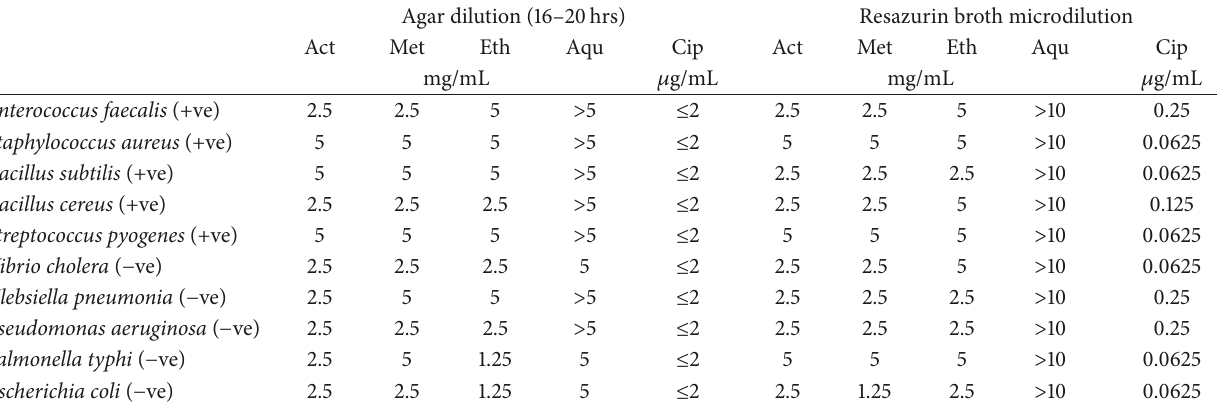
Table 1: Minimum Inhibitory Concentrations (MIC) of the different solvent extracts of P. capitata on selected gram-negative and gram- positive bacteria using the agar and resazurin broth dilution